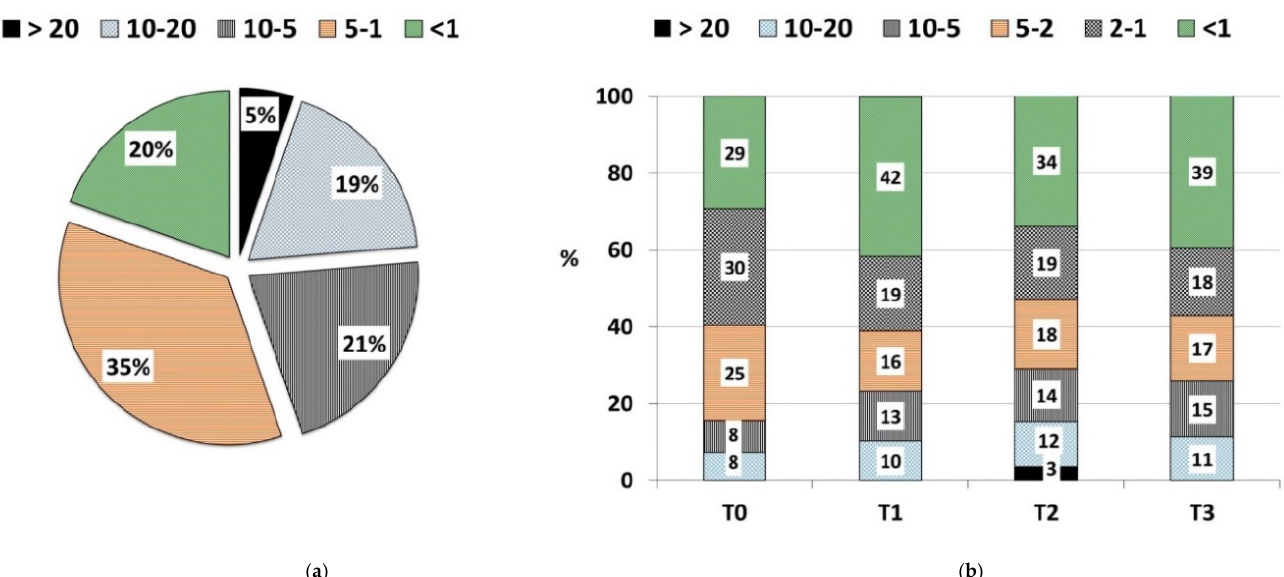
Figure 2. Particle size (mm) distribution: ( a ) final compost (% weight); ( b ) growing media: T0 (control—100% peat substrate); T1 (25% compost, 30% sphagnum peat, 15% fen peat, 20% pine bark, 10% wood fiber); T2 (30% compost, 20% sphagnum peat, 30% fen peat, 10% pine bark, 10% wood fiber); T3 (30% compost, 0% sphagnum peat, 30% fen peat, 30% pine bark, 10% woody fiber) (% weight).